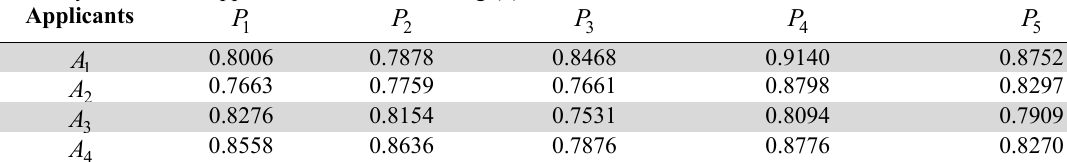
Similarity measure of Applicants vs. Positions using (2)